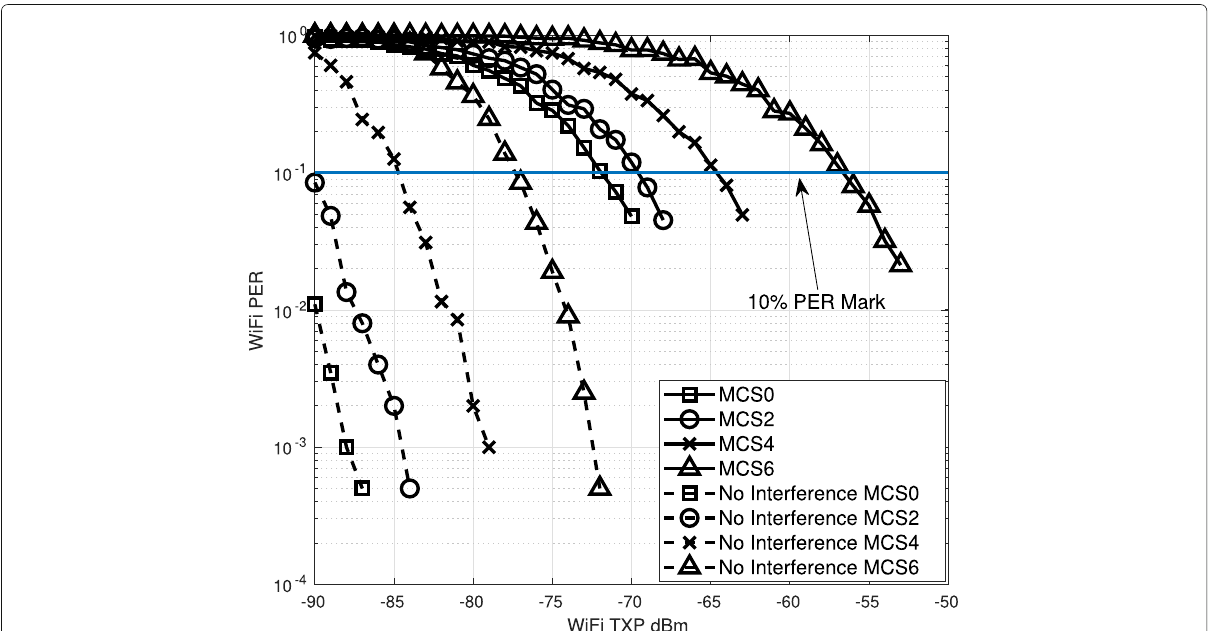
Fig. 2 PER of single antenna WiFi receiver in the presence and absence of single antenna ZigBee transmitter(transmit power -85 dBm). For all WiFi MCS, we observe severe PER degradation